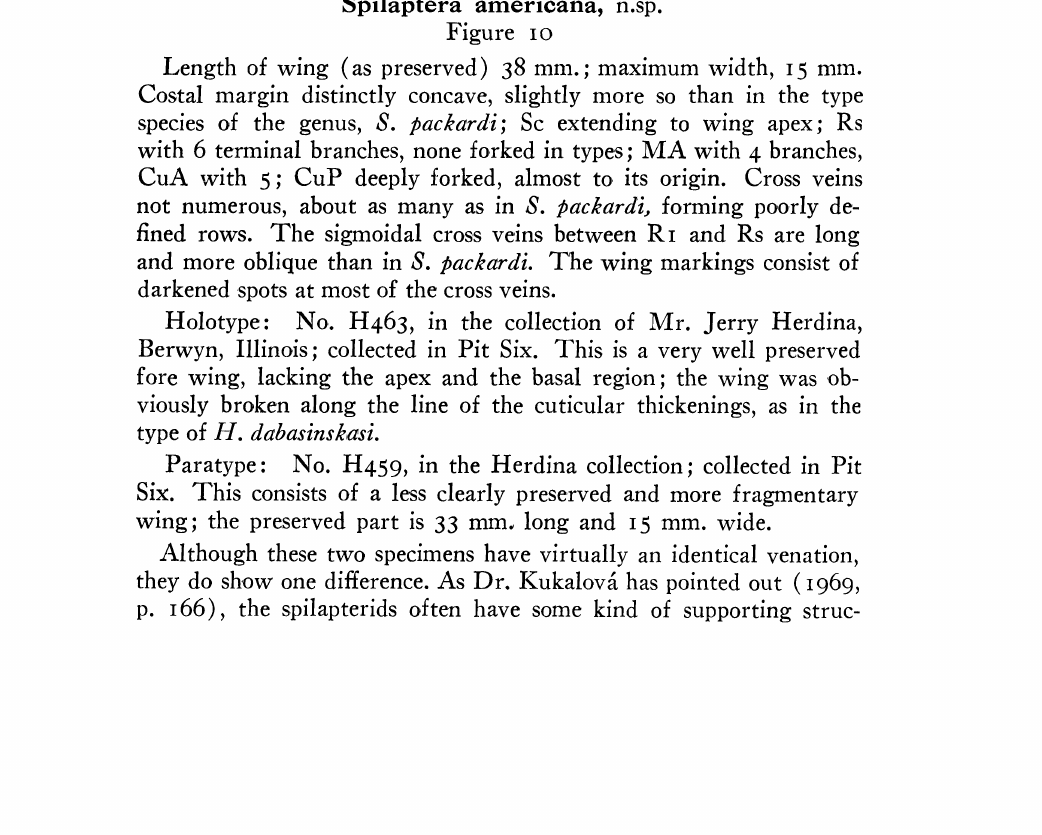
Figure 10. SlilaDte,ra americana, n.sp. Drawing of holotype, No. H 463, Herdina collection. Length of wing as preserved, 38 mm. and o.blique cross veins present and it is accordingly placed in the genus 8pilaptera. The several other known genera of Pennsylvanian Spilapteridae, including Mcluckiepteron, have very distinctive fea- tures, such as numerous cross veins, more extensive branching of veins, pronounced tapering of wing,